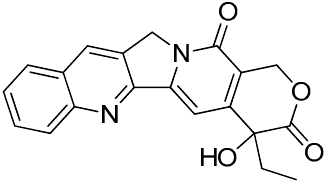
Figure 3. Camptothecin.